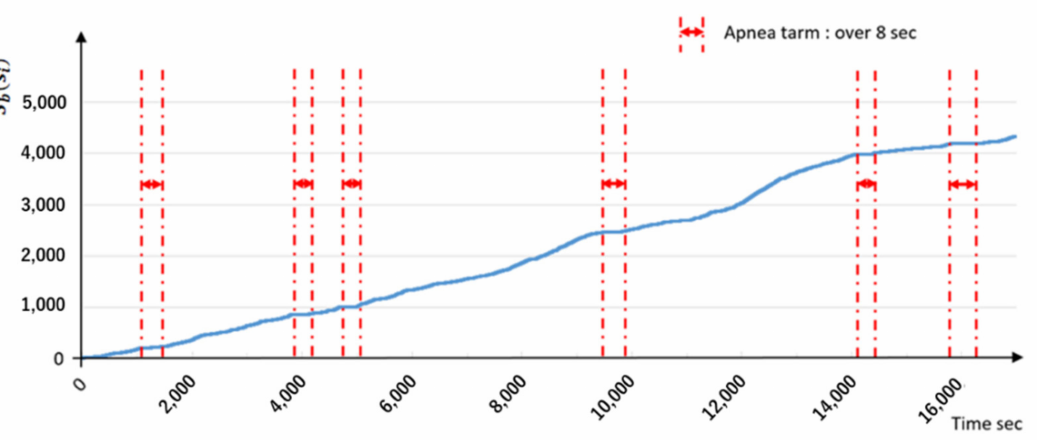
Figure 2. Example of visualizing the respiratory state of breathing sound during sleep of an SAS- affected